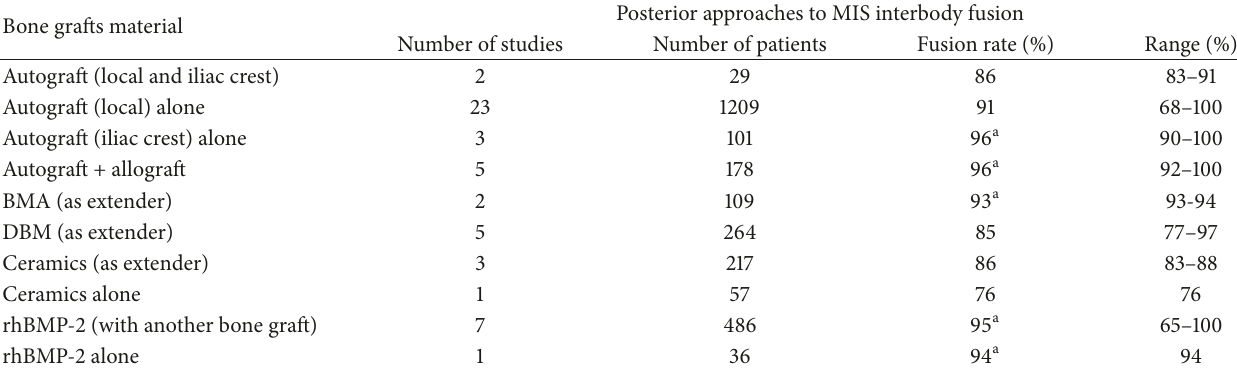
Table 1: Fusion rates for various bone grafts in posterior approaches to minimally invasive interbody fusions. Bone grafts material